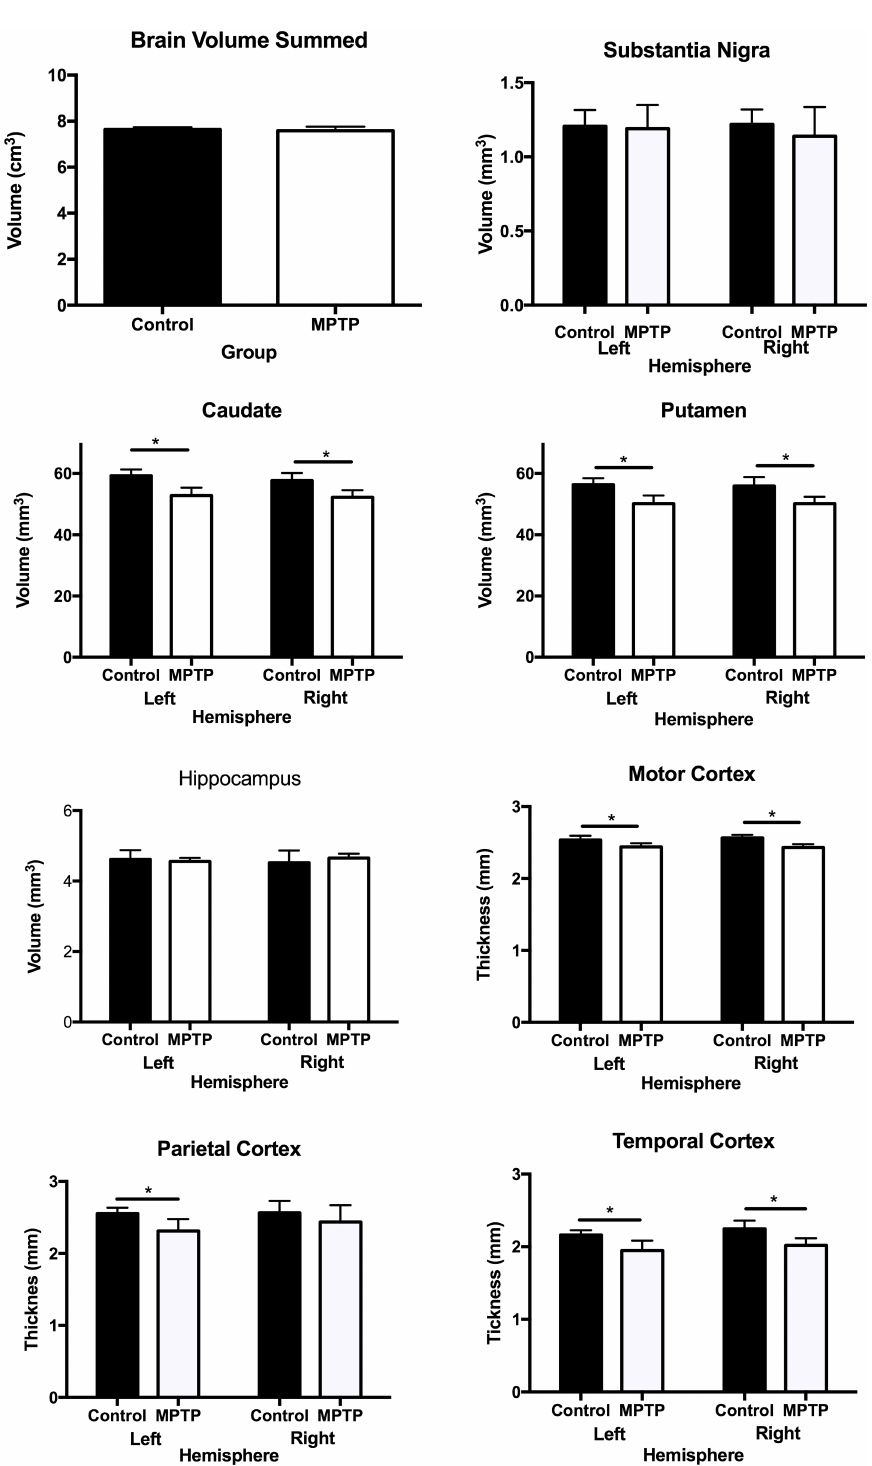
Fig 4. Quantification of anatomical changes due to MPTP treatment. Volumetric analysis(mean +standard deviation) indicatedthat MPTP treatment did not affect wholebrain volume, substantianigra or hippocampal volume. Nevertheless, a significant(p < 0.05)atrophy of was evidentin both the caudate(-12%) and the putamen (-11%). There was no lateralityeffect with both left and right hemispheres showingthe same degreeof neurodegeneration. There was also a significanteffect in motor (p < .05), parietal(p < 0.05)and